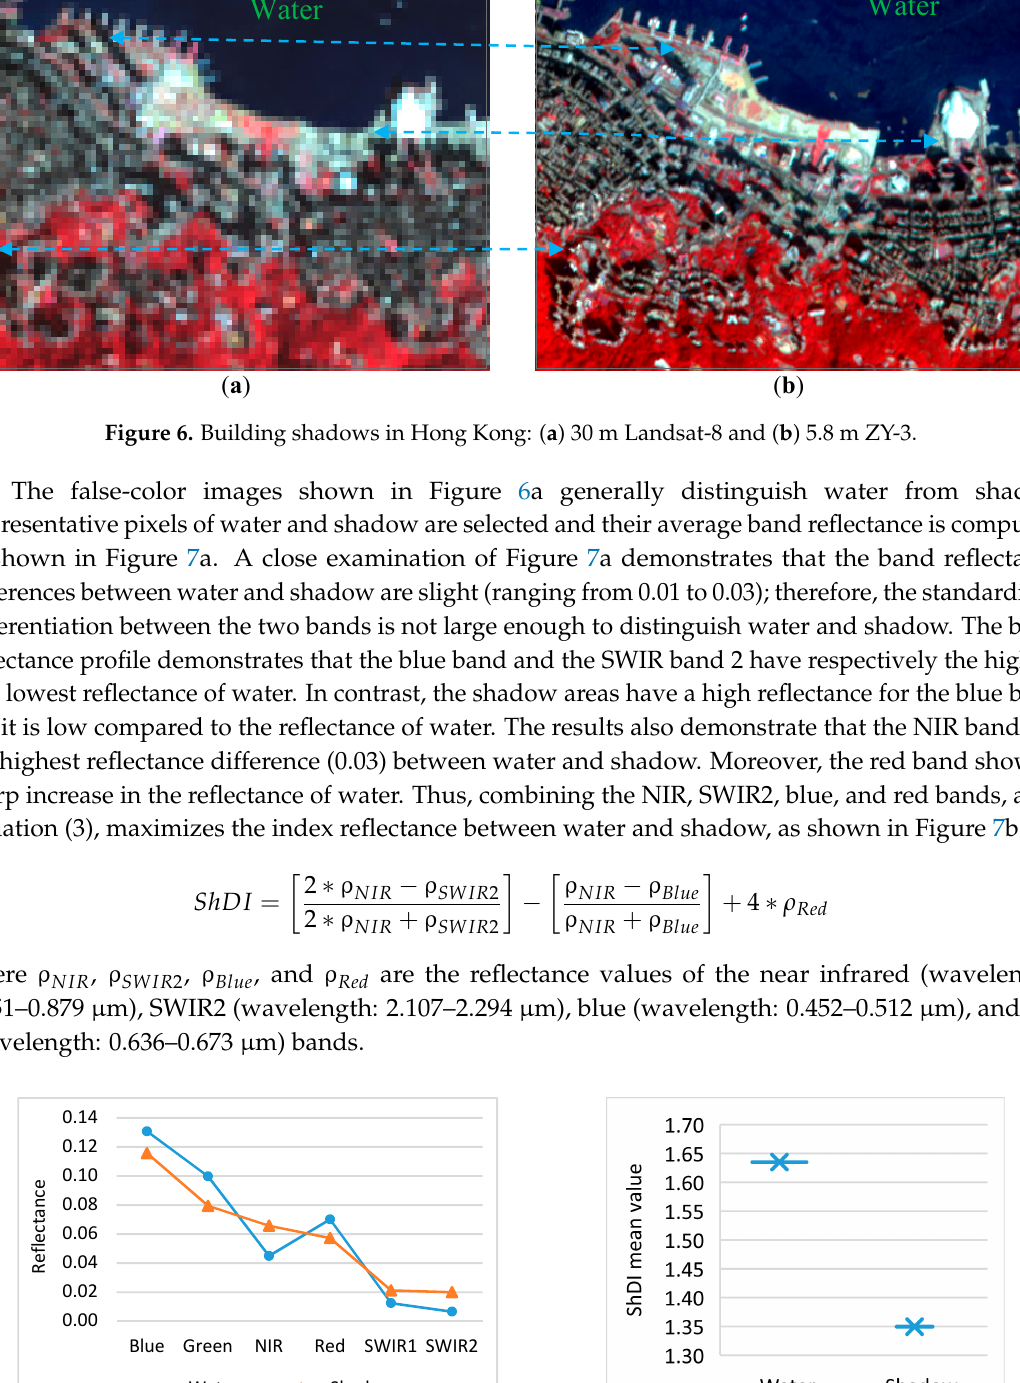
( b ) Figure 5. Reflectance of the typical land cover types in the Hong Kong study area: ( a ) index values and ( b ) proposed tasseled cap water and vegetation index (TCWVI). 3.3.3. Shadow Index (ShDI) Shadows are in general less significant in land cover mapping that uses low-resolution imagery. However, in metropolitan cities such as Hong Kong, skyscrapers throw shadows that create problems in the analysis of low-resolution images, as shown in Figure 6(a). Shadowed areas have reflectance that is similar to water, and it can be difficult to distinguish them in land cover mapping. Many shadow detection techniques [58, 59] are available for high-resolution images (HRI), however, none are available for low-resolution images (LRI). For example, He et al. [59] detected shadows using object-based classification. In contrary, Li et al. [58] used vectorization algorithms based on object shape features to remove shadow and other noises from water. However, none of these methods is favorable to LRI. Therefore, to improve the accuracy of water extraction in urban areas, we develop